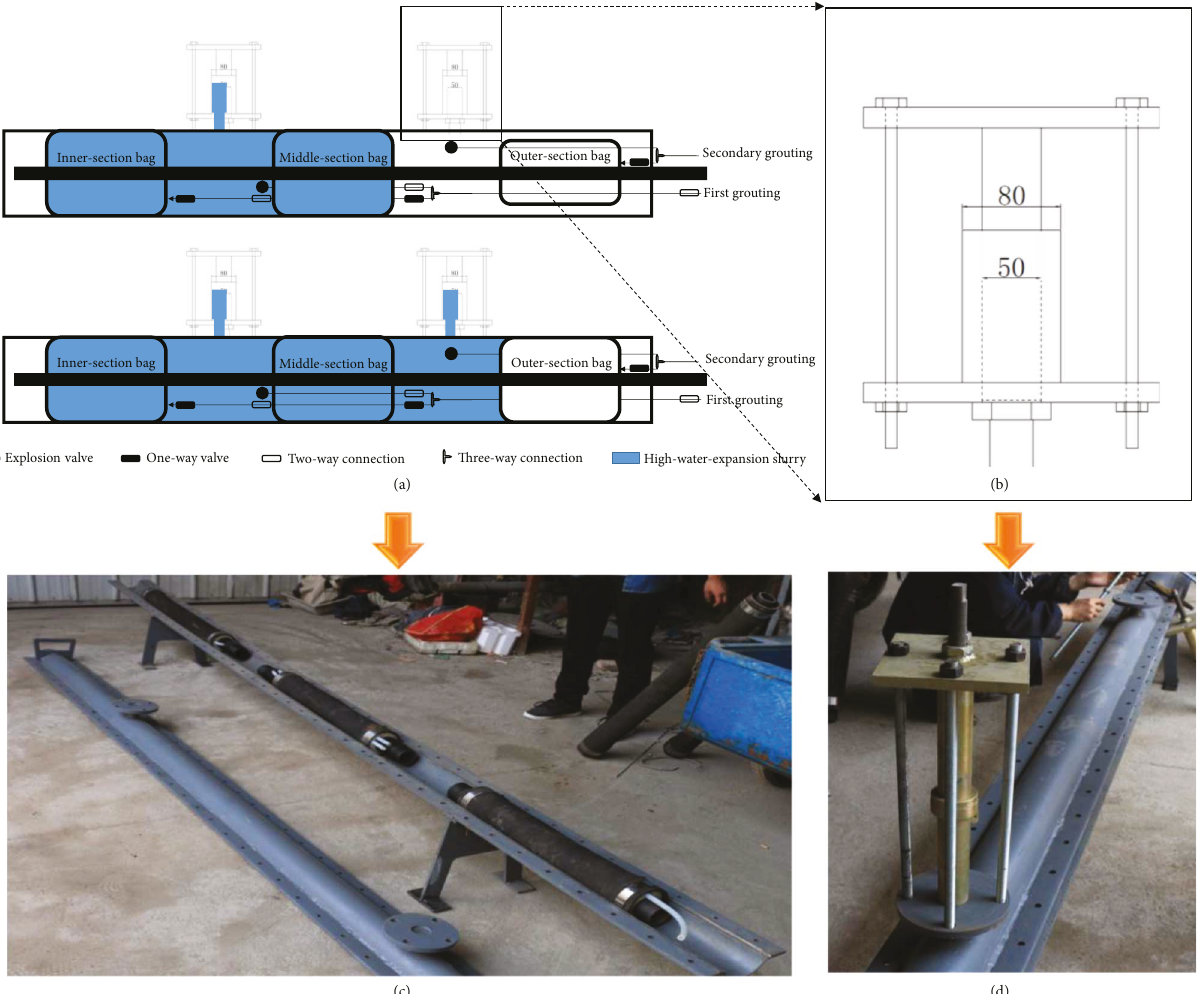
Figure 7: Schematic and photographs of the experimental device. (a, c) Secondary borehole sealing device. (b, d) Additional